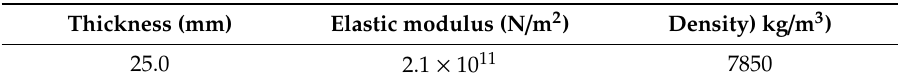
Table 5. The property of model.